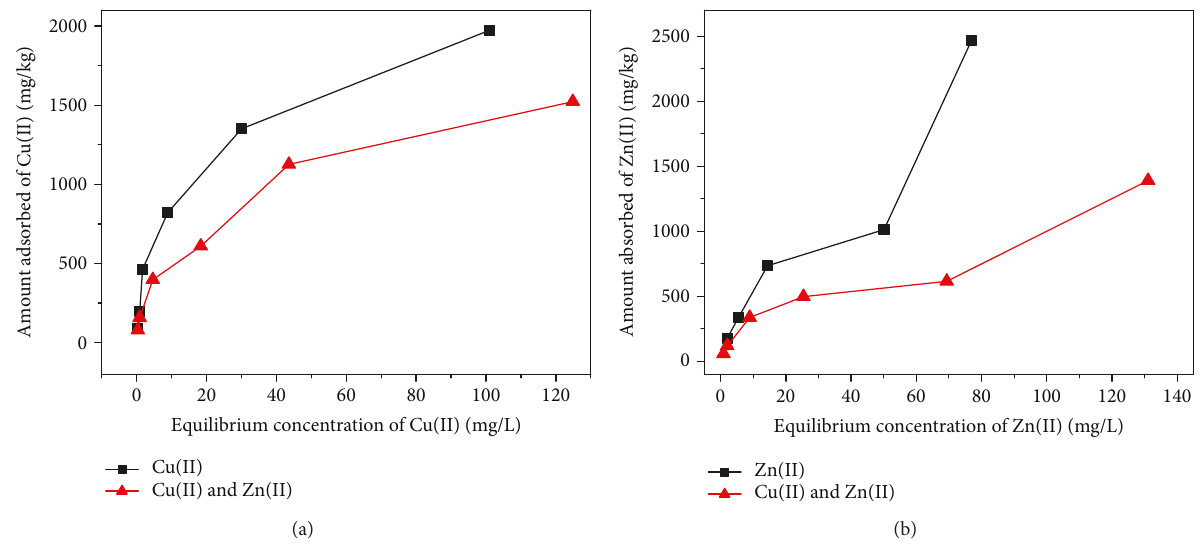
Figure 7: Adsorption in single-metal solution and the binary-metal solution: (a) adsorbed amount of Cu(II) and (b) adsorbed amount of